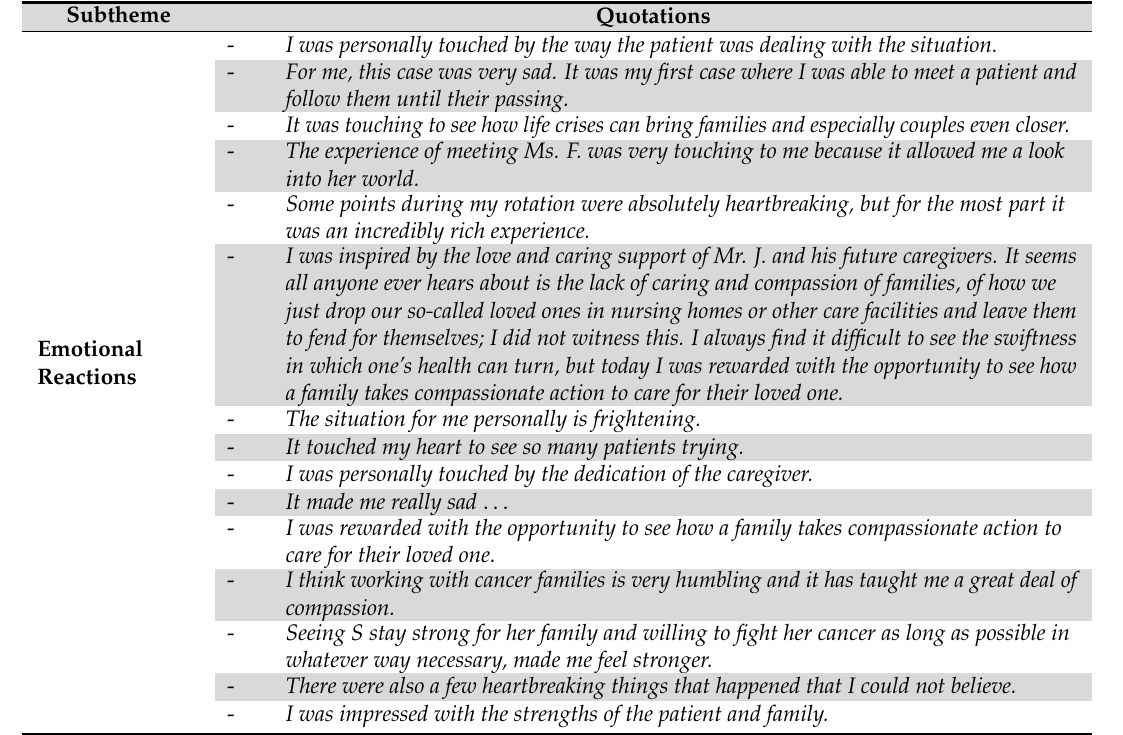
Table 10. Quotes related to the subtheme of emotional